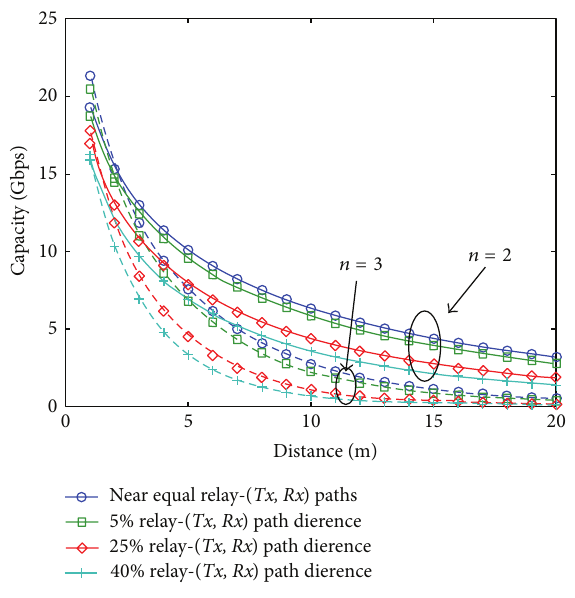
Figure 4: Relay to (𝑇𝑥,𝑅𝑥) distance analysis.